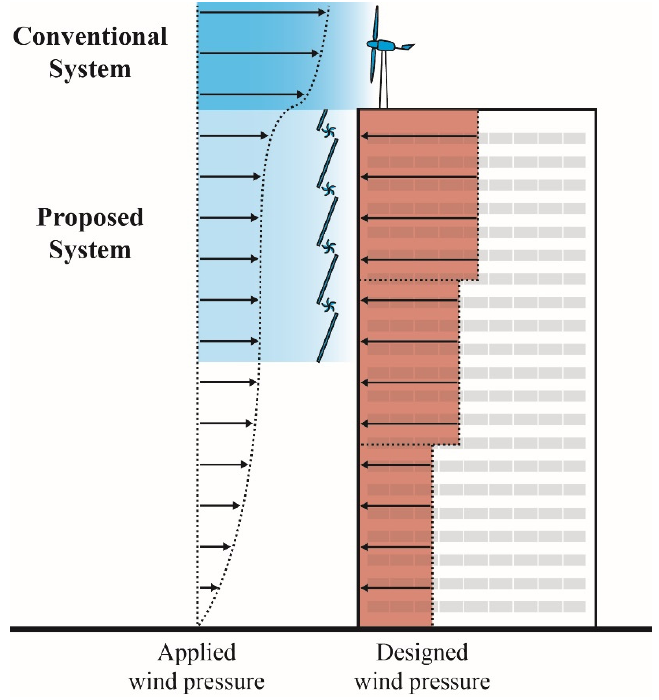
Figure 4. Structural aspect of the proposed